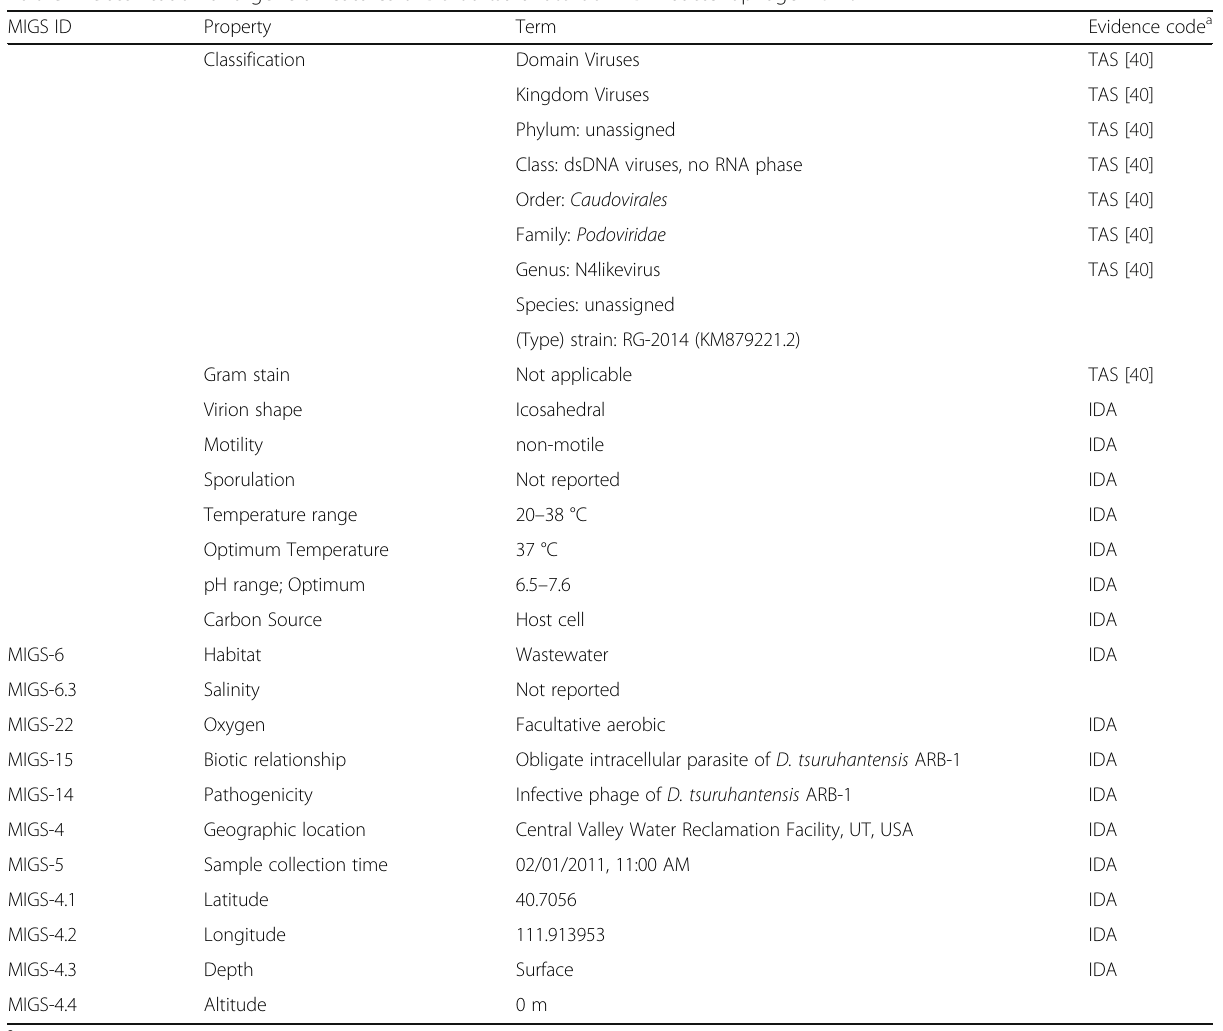
Table 1 Classification and general features of Delftia tsuruhatensis ARB-1 bacteriophage RG-2014 MIGS